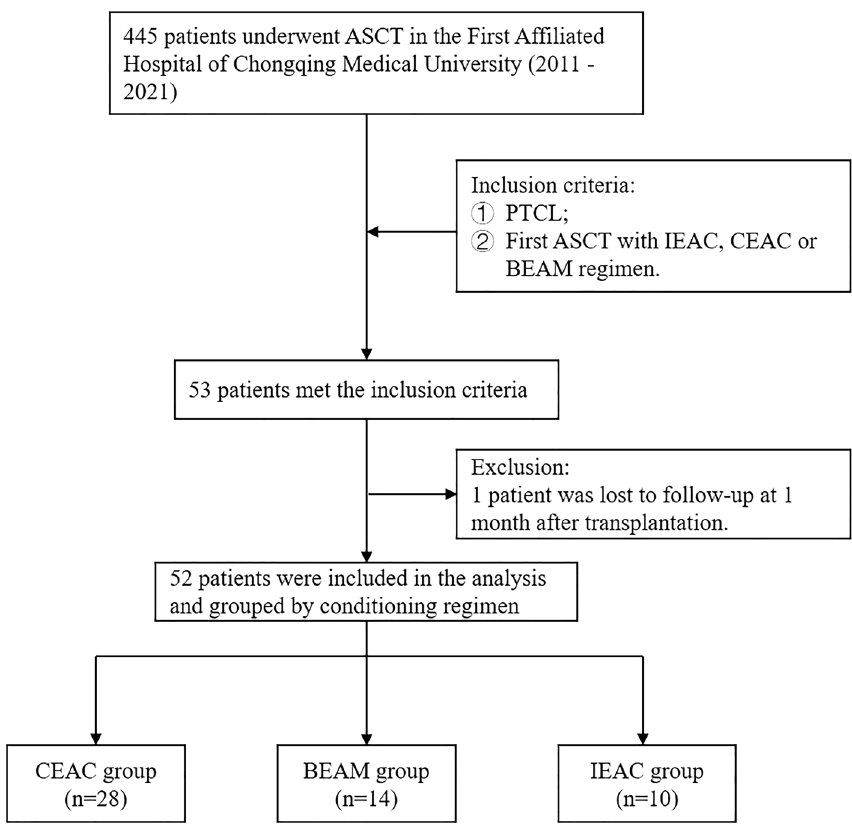
Figure 1. Diagram showing the flow of study